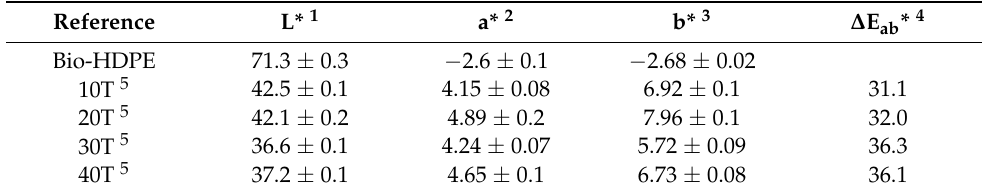
Table 6. Colour coordinates (L*, a*, b*) for different weight percentage of treated chia seed flour with